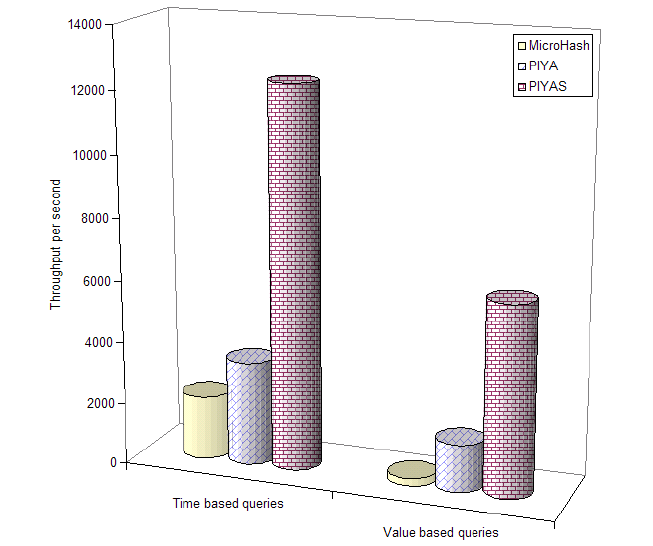
Figure 9. Data throughput per second from